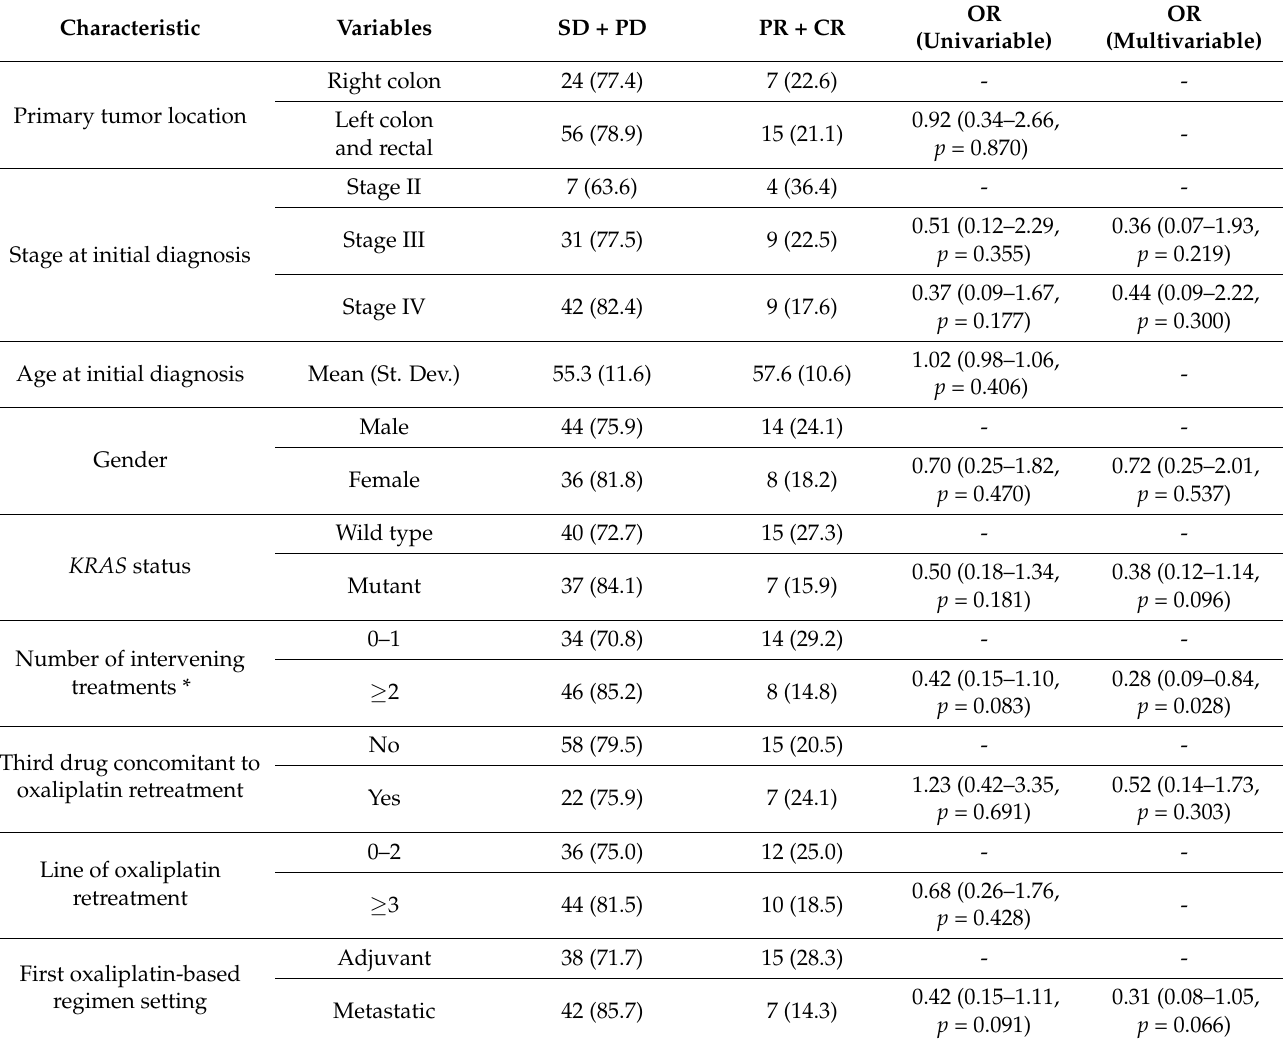
Table 1. Odds ratios at univariate and multivariate analyses of metastatic colorectal cancer patients who were evaluable for response rate (RR) with oxaliplatin retreatment. Keys: SD = stable disease; PR = partial response; CR = complete response; PD = progressive disease; St. Dev = standard deviation; OR = odds ratio. * = statistically